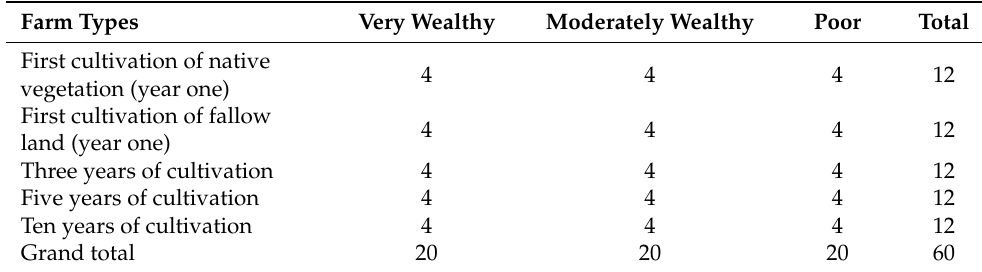
Table 1. Farm types, corresponding wealth rankings and numbers of farms per wealth ranking and farm